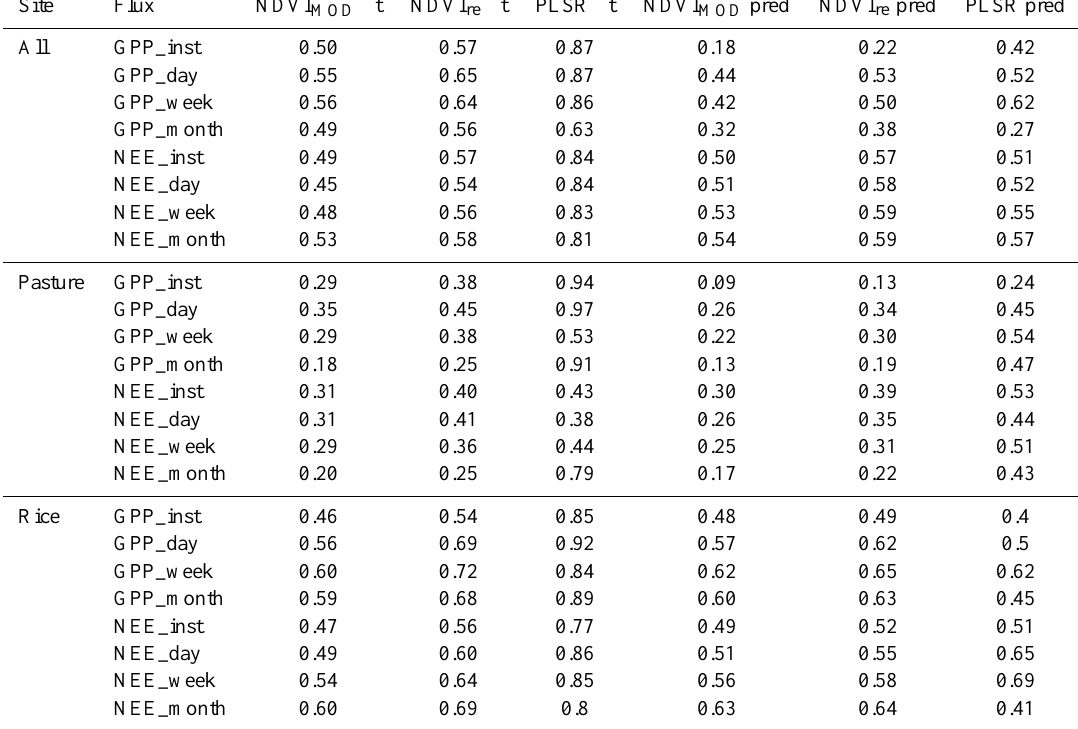
Table 3. Comparison of SVIs and PLSR model skill. We evaluated the ability of the commonly used standardized vegetation indices (SVIs) to predict GPP and NEE in comparison with the PLSR models. Here we show the calibration fit R 2 (fit) and predictive R 2 (pred) values for the widely used MODIS NDVI (NDVI MOD ) and the red-edge NDVI (NDVI re ) , which was the SVI that achieved the highest skill at predicting GPP and NEE. Results from all SVIs tested in this study are included as Supplement Table S1. “inst” stands for